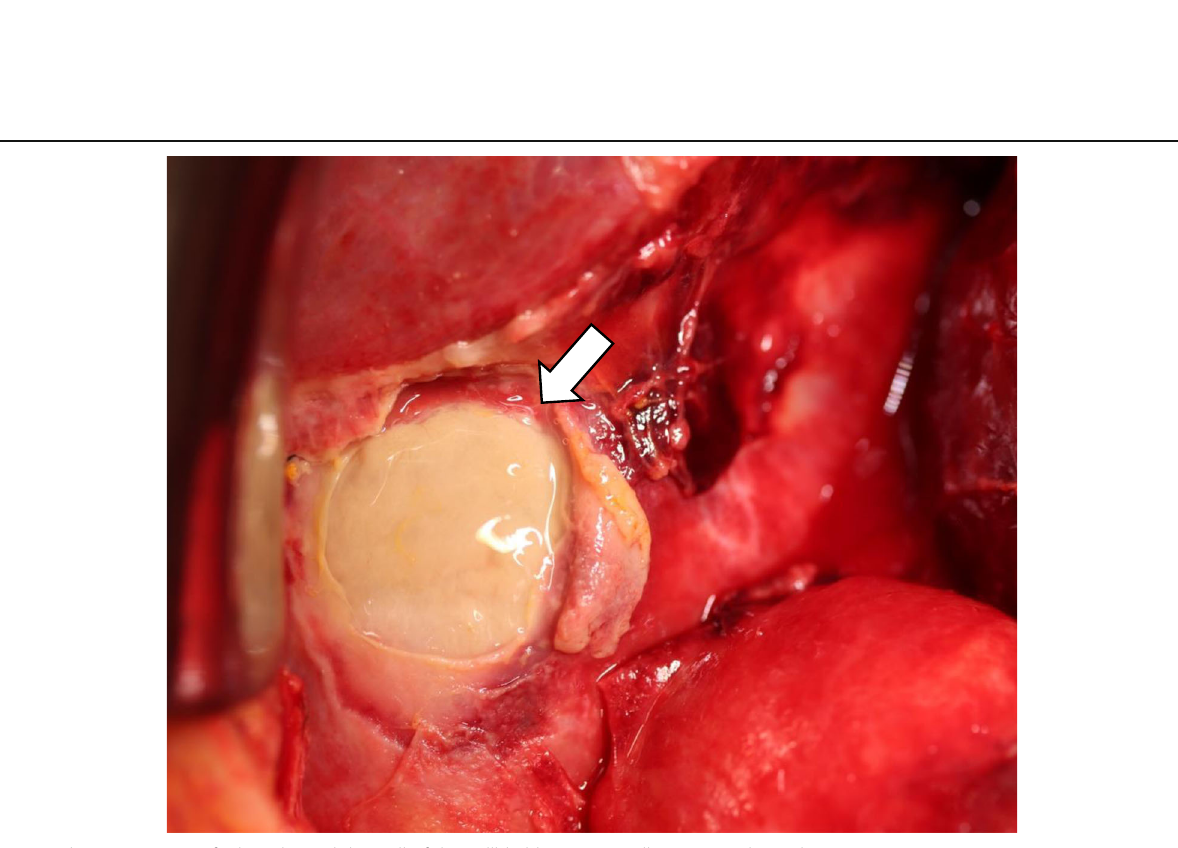
Fig. 4 The intraoperative finding showed the wall of the gallbladder was partially necrotic (shown by